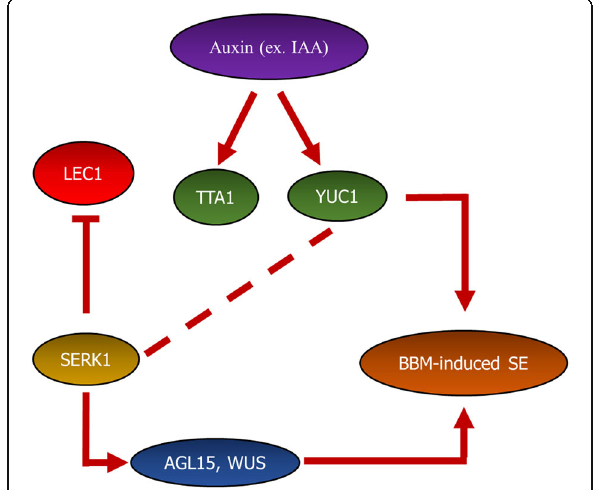
Fig. 3 Auxin signalling and its possible involvement in BBM induced somatic embryogenesis. Solid arrows show the positive regulatory role whereas the dashed line represents the regulatory role between SERK1 and BBM that has not been investigated yet. SERK1 had inhibitory effect on LEC1, LEC2 and FUS3. SE: Somatic embryogenesis. The figure has been conceptulized and drawn using scientific literatures by Ayil-Gutiérrez et al. (2013) and Pérez-Pascual et al.